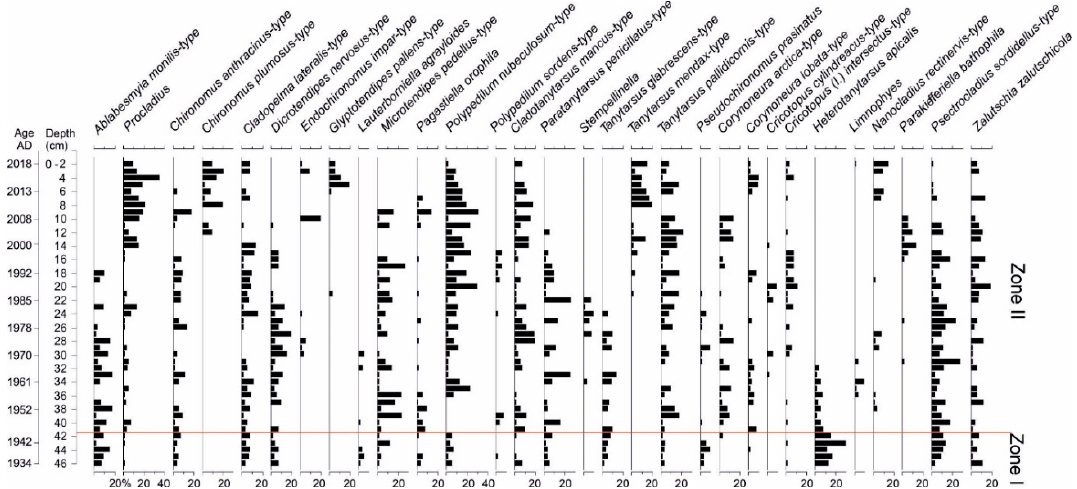
Figure 10. Relative abundance of Chironomidae in Lake Sekšu sediment.